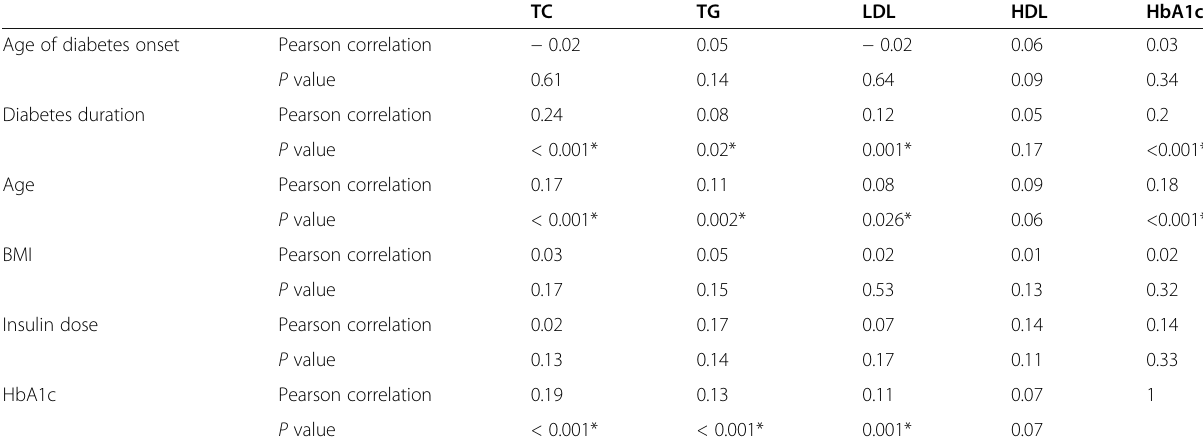
Table 4 Correlations between the lipid profile and the demographic parameters and glycemic